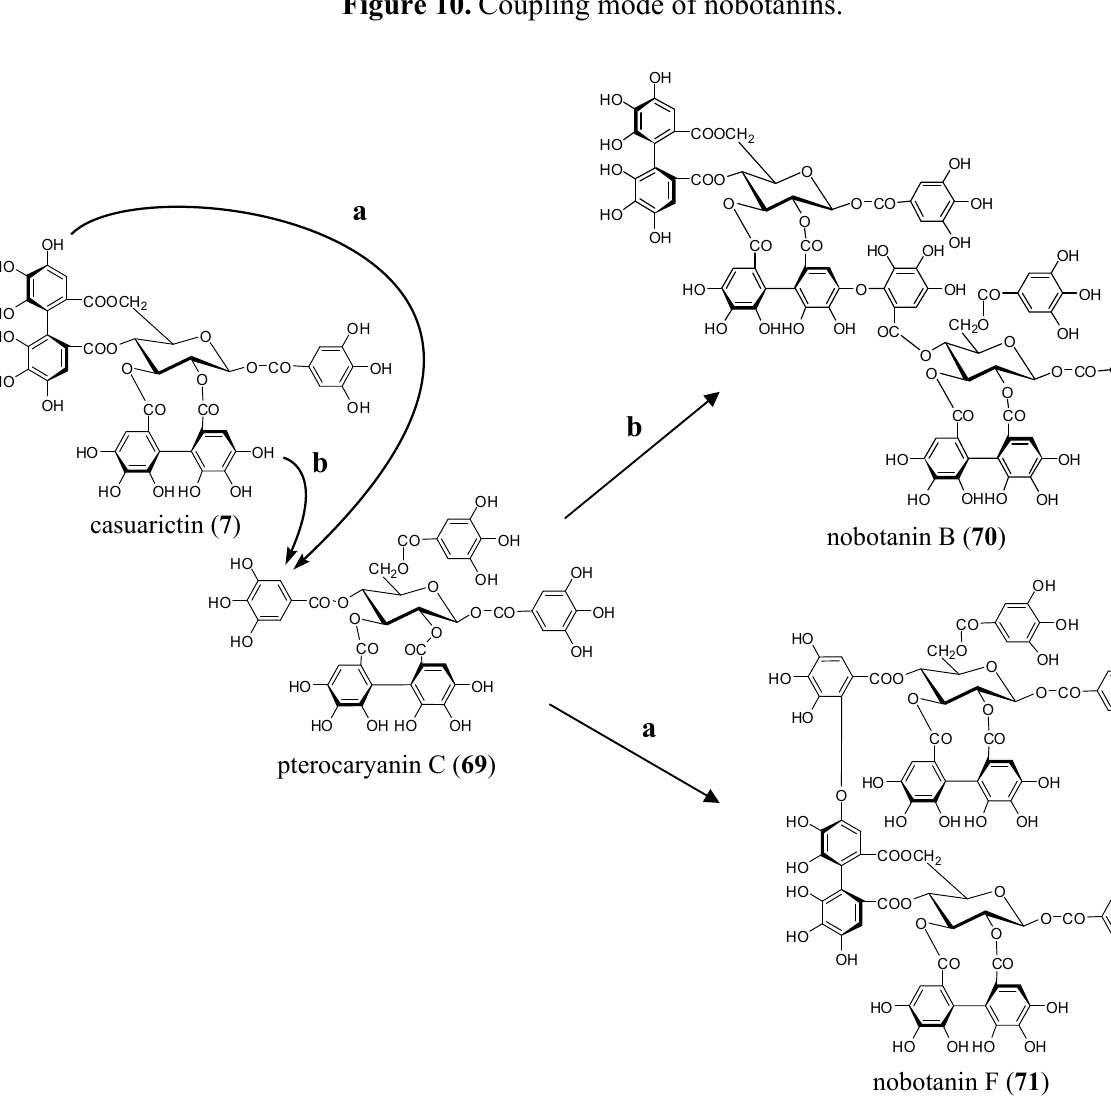
Figure 10. Coupling mode of